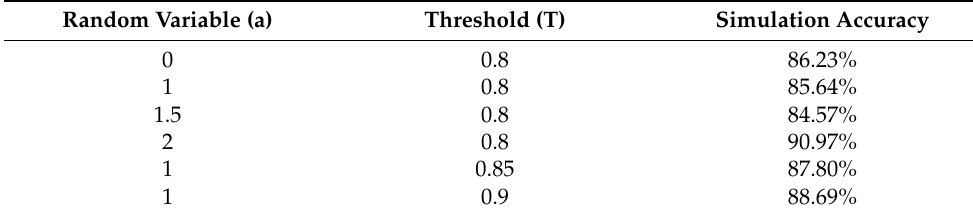
Table 9. Model accuracy under different parameter combinations.